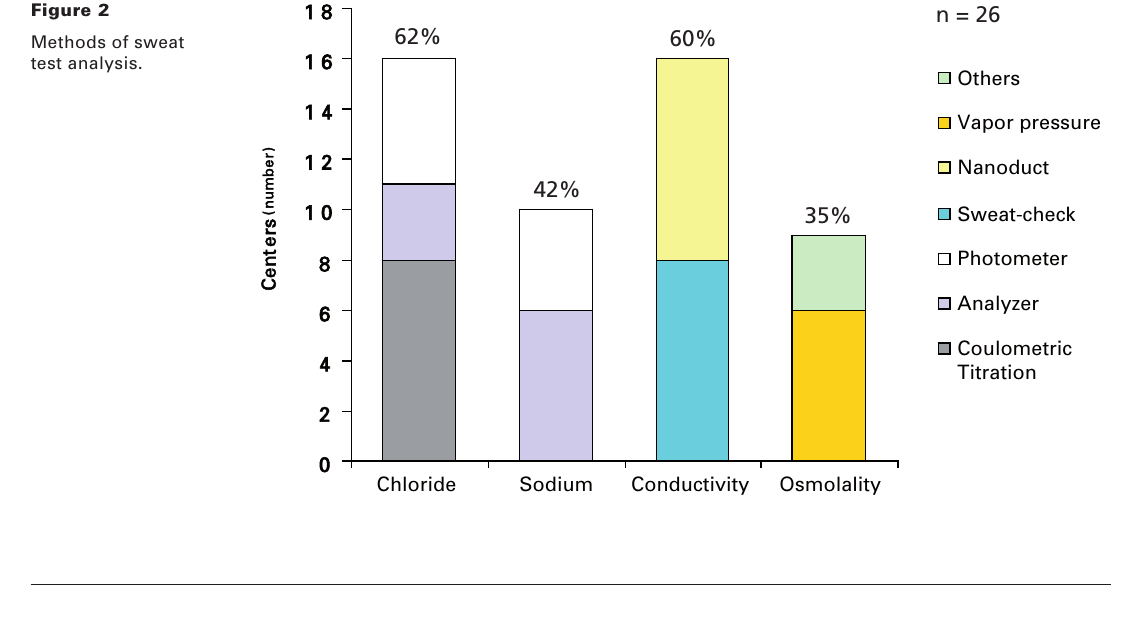
Figure 3 Sweat test – chloride